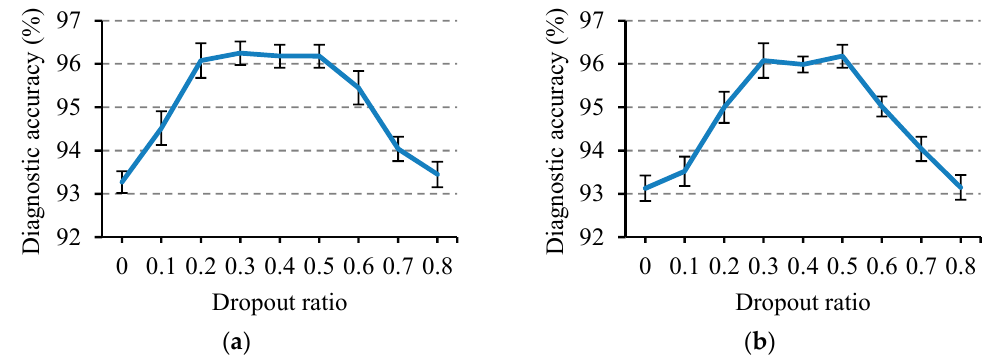
Figure 9. Diagnostic accuracy when the dropout parameters of the first two layers change: ( a ) the dropout ratio of the first layer Dropout1 and ( b ) the dropout ratio of the second layer Dropout2 .